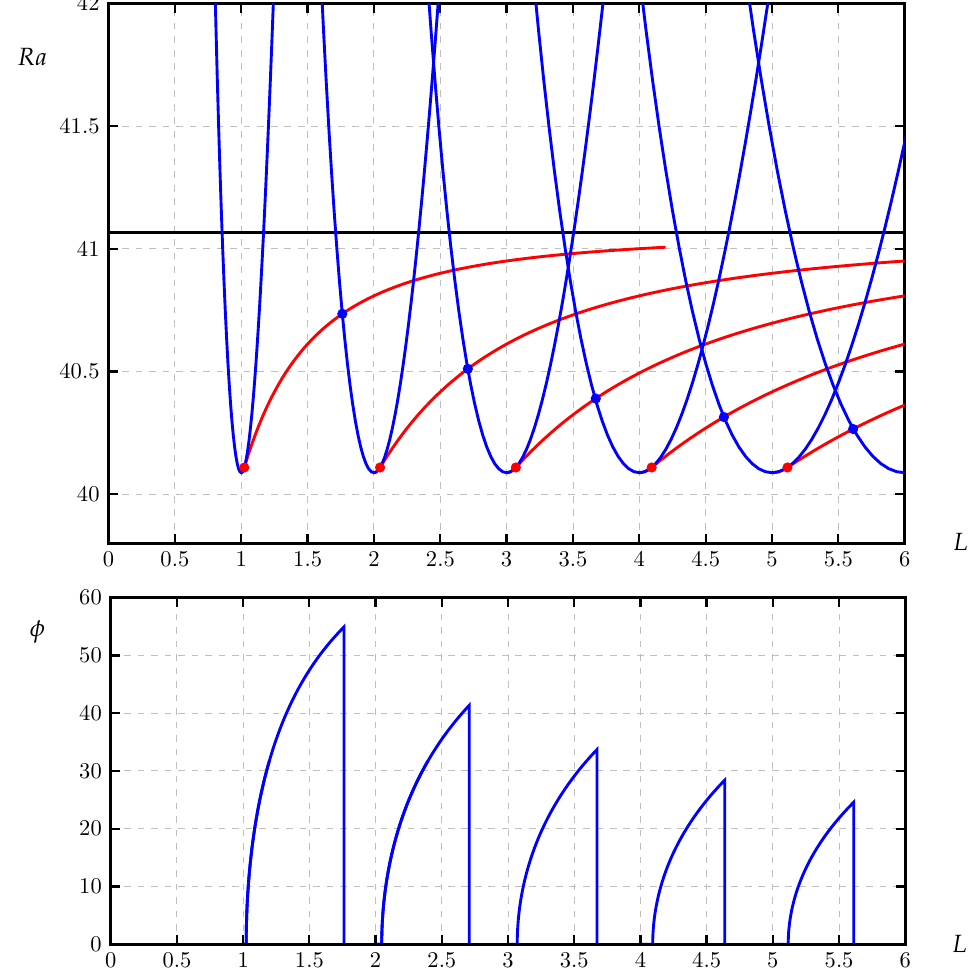
Figure 4. Showing the variation of Ra and φ against L when α = 10 ◦ . For the curves for Ra, blue indicates longitudinal rolls, while red indicates oblique rolls and black the transverse roll. The disks denote the beginning and ending of the ranges within which oblique rolls are